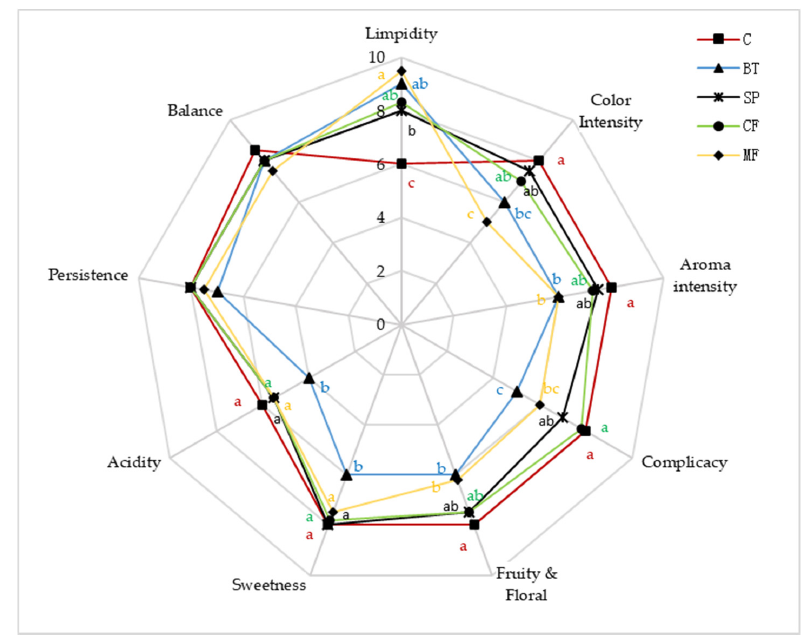
Figure 4. Radar map of sensory analysis. Different letters represent significant differences at a significant level of 0.05.